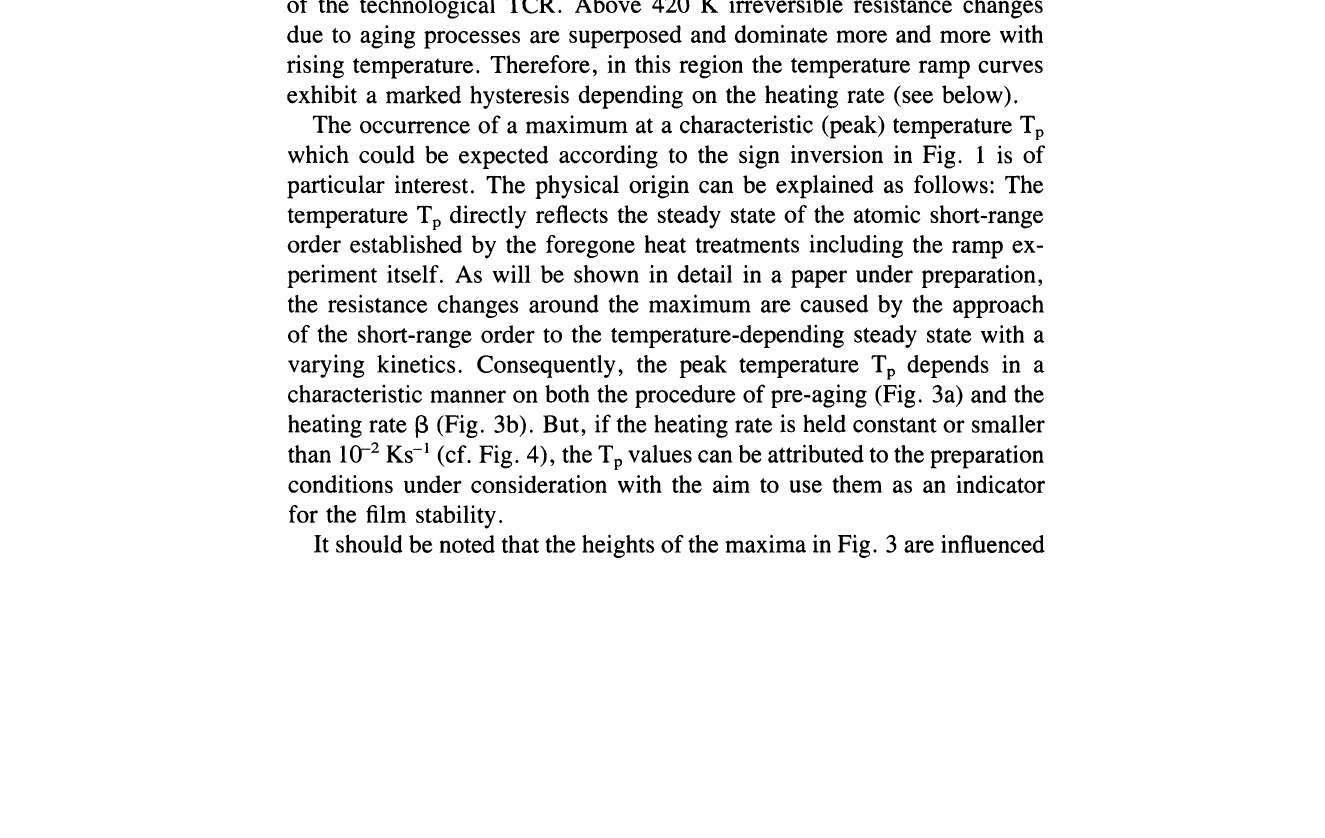
FIGURE 4 Dependence of characteristic temperature Tp on the heating rate 13 of two experimental runs (different additional isothermal treatments); Ni/Cr 33/67